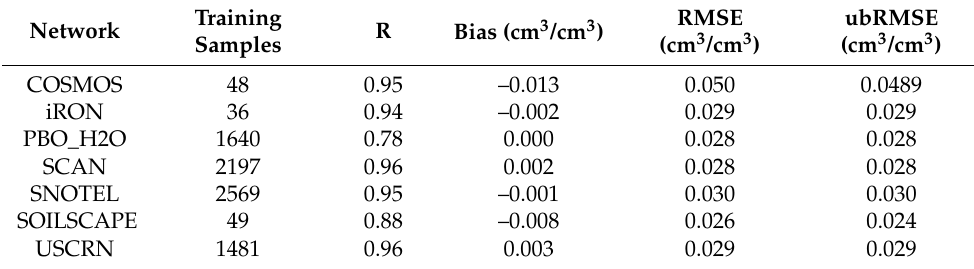
Table 6. Average statistics of the evaluation of SM retrieval against in-situ measurements over each